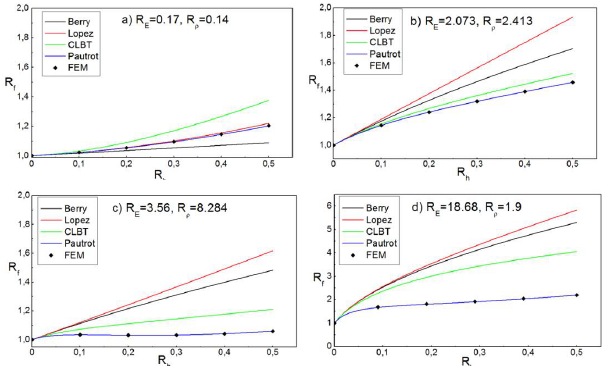
Figure 1. Comparison between analytical and numerical models for different Young’s modulus and